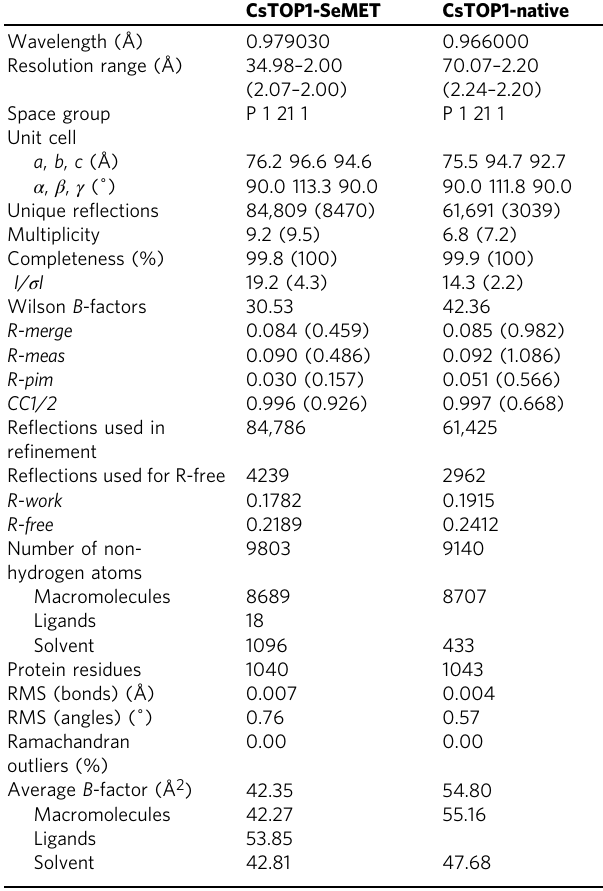
Table 2 Data collection and re fi nement